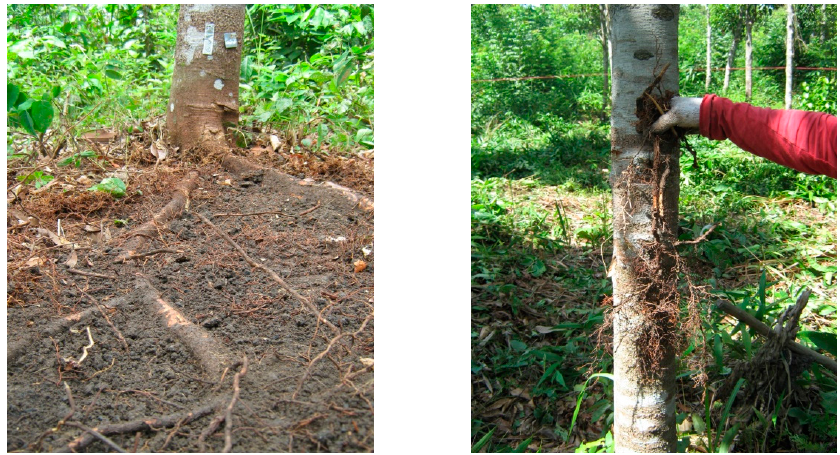
Figure A16. ( Left ) Excavation and ( Right ) collection of rosewood lateral roots in Central Amazonian commercial plantations.